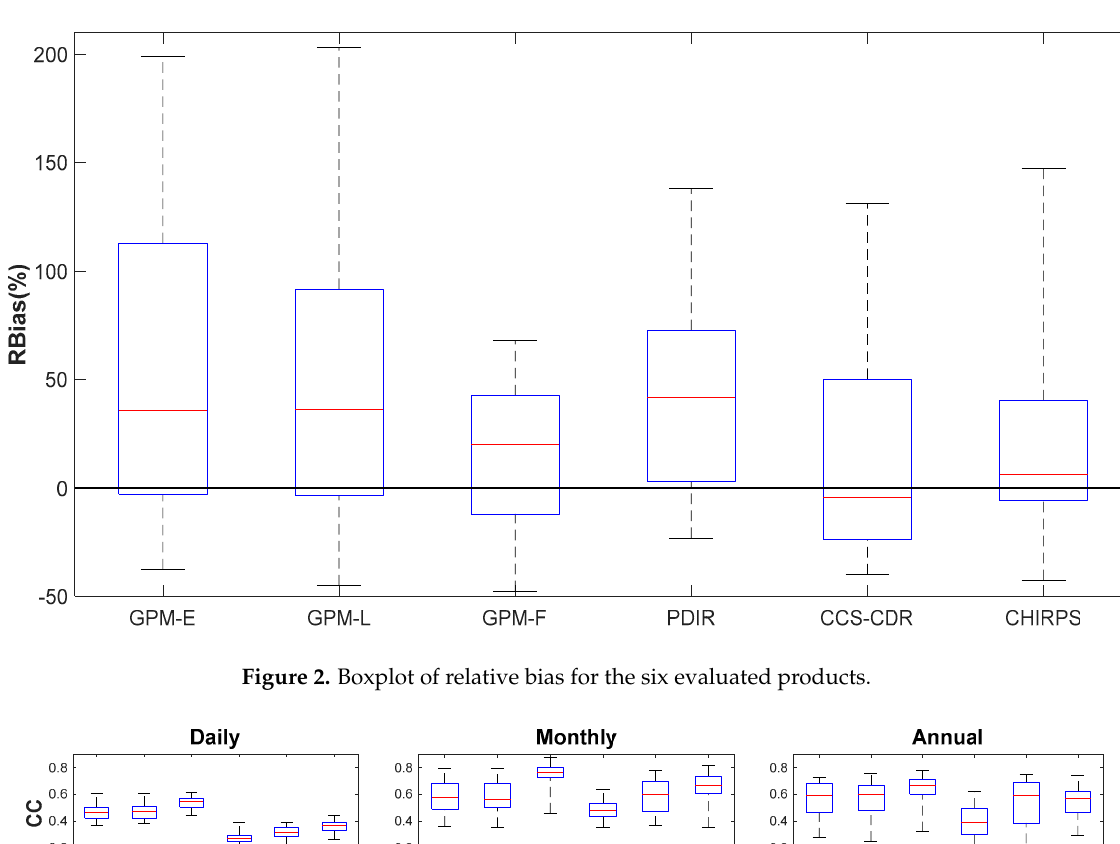
Figure 2. Boxplot of relative bias for the six evaluated products.